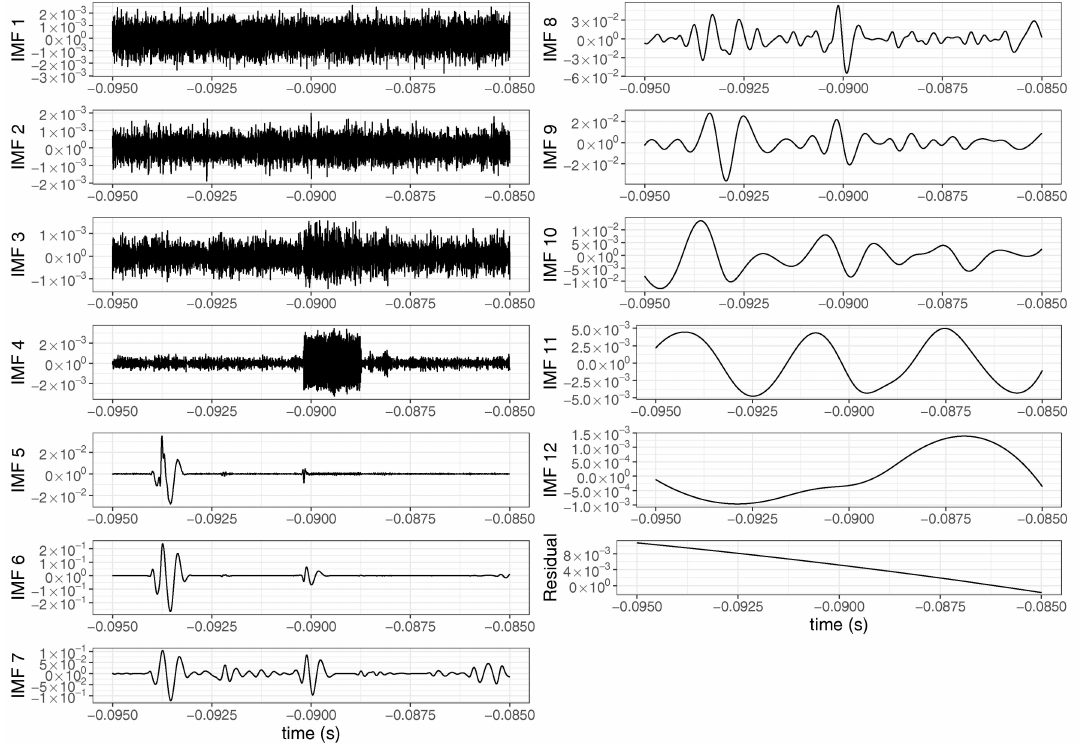
Figure 12. IMFs extracted with the EEMD procedure.